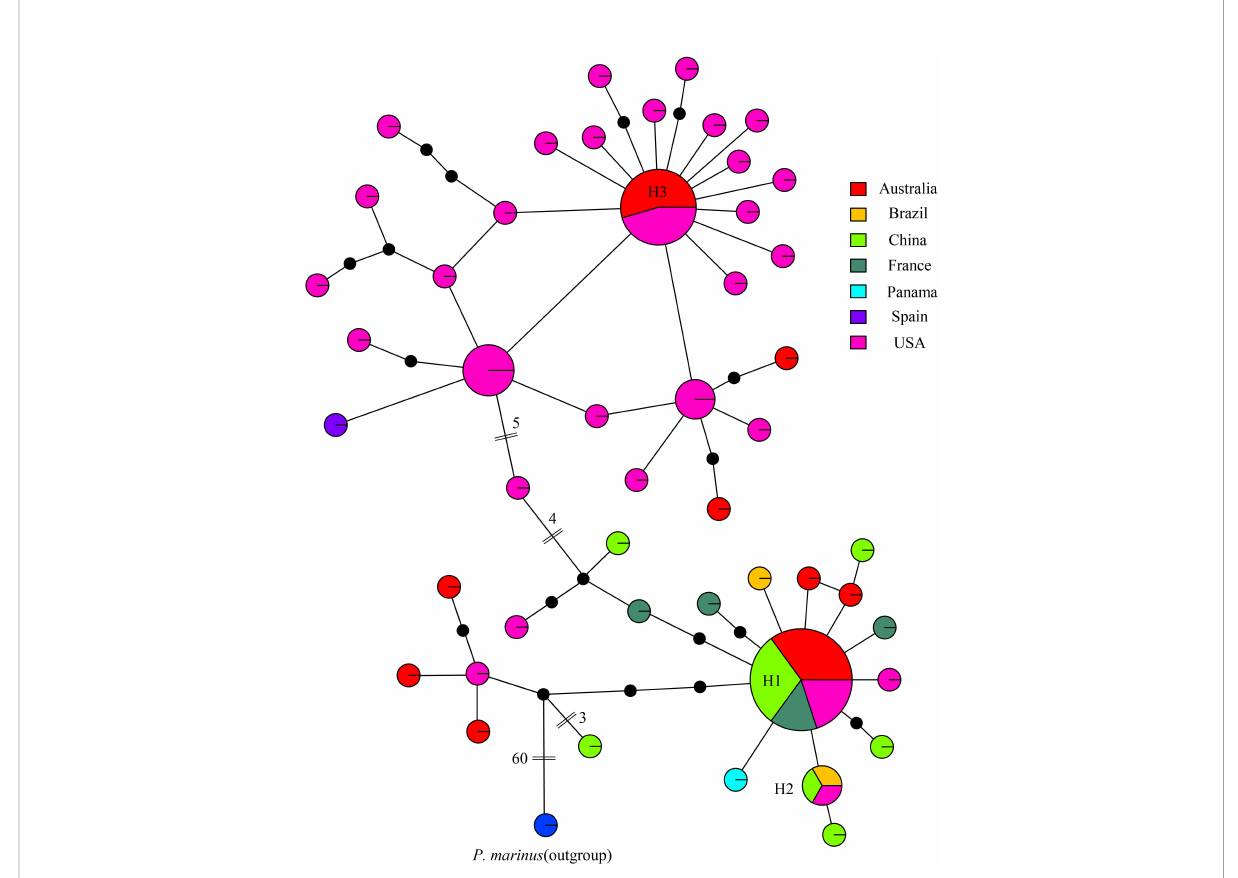
FIGURE 6 Haplotype networks of Perkinsus chesapeaki based on internal transcriber spacer sequence. Colors indicate countries sampled. Neighboring haplotypes without double cross-bars indicate a single nucleotide mutation step or a gap. A nucleotide mutation step or gap of >1 between neighboring haplotypes was marked with double cross-bars, and the total numbers are indicated beside it. Black circles indicate inferred haplotypes not found in the sampled populations. Shared haplotypes are marked from H1 to H3 beside or inside the pie charts. The areas of the circles are proportional to the number of samples of each haplotype. Perkinsus marinus was used as the